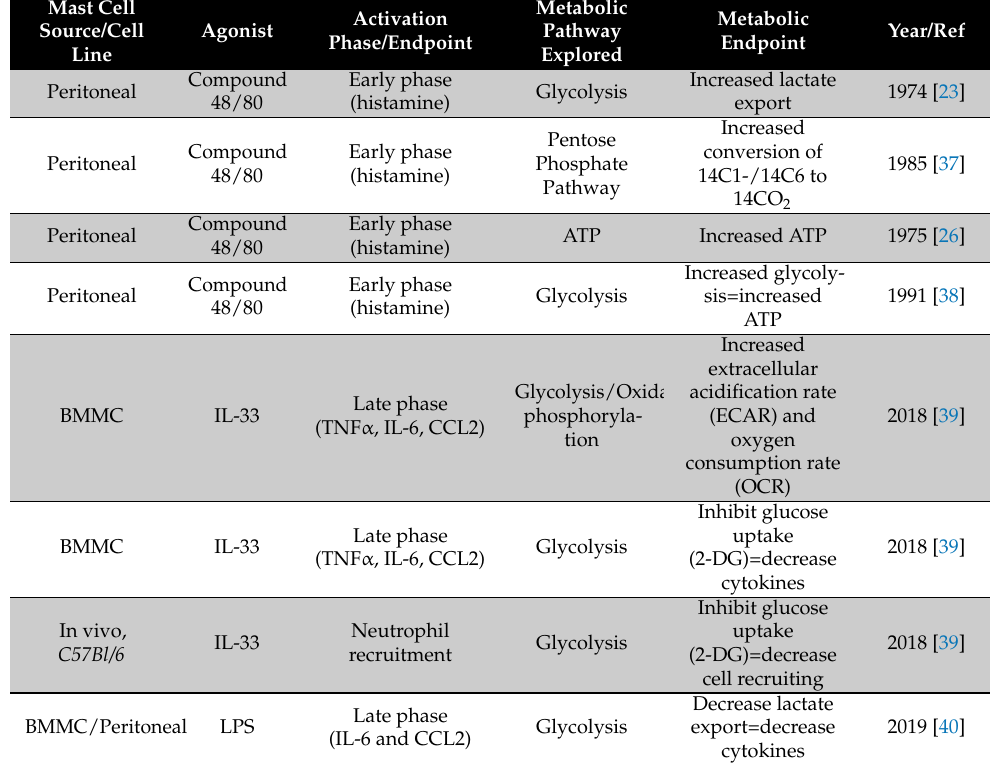
Table 2. Summary of studies exploring energy metabolism changes in non-IgE mediated mast cell